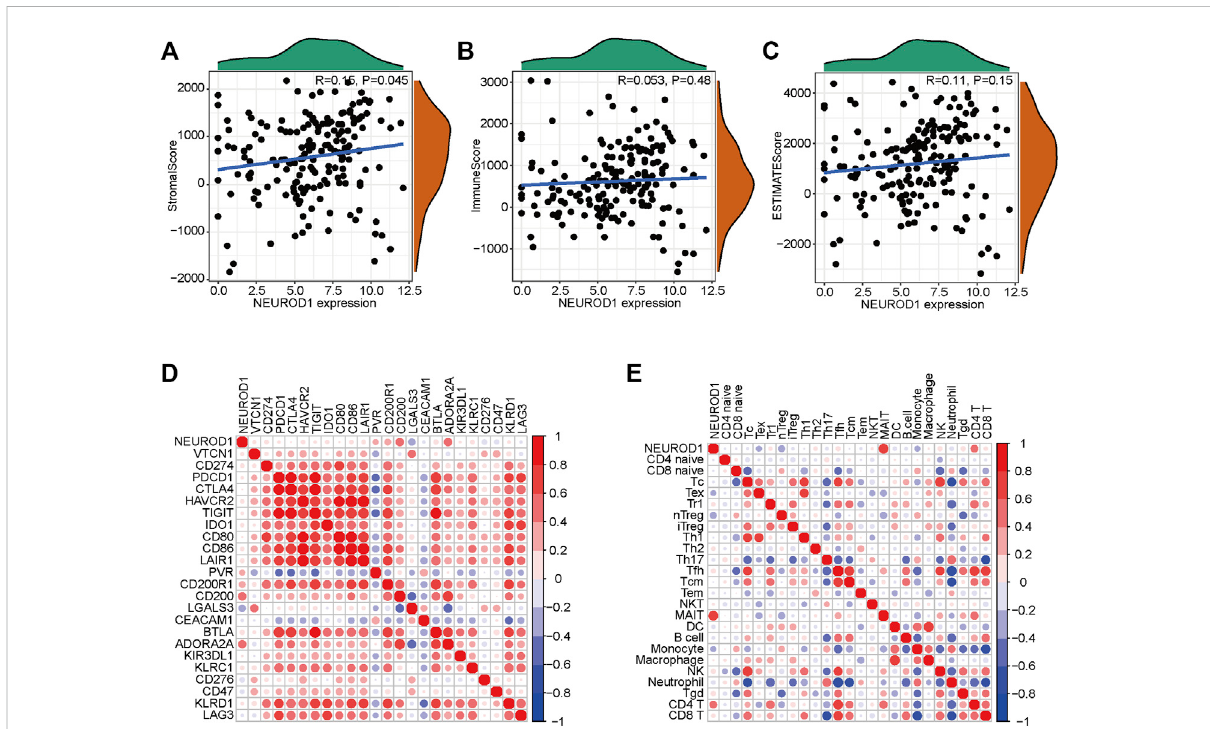
FIGURE 4 NEUROD1 was not related to anti-tumor immunity in the TCGA dataset. (A – C) Association between NEUROD1 expression and stromal score, immune score, and ESTIMATA score in the TCGA dataset. (D,E) Association between NEUROD1 expression and immune checkpoints expression as well as immune cell in fi ltrations in the TCGA dataset.